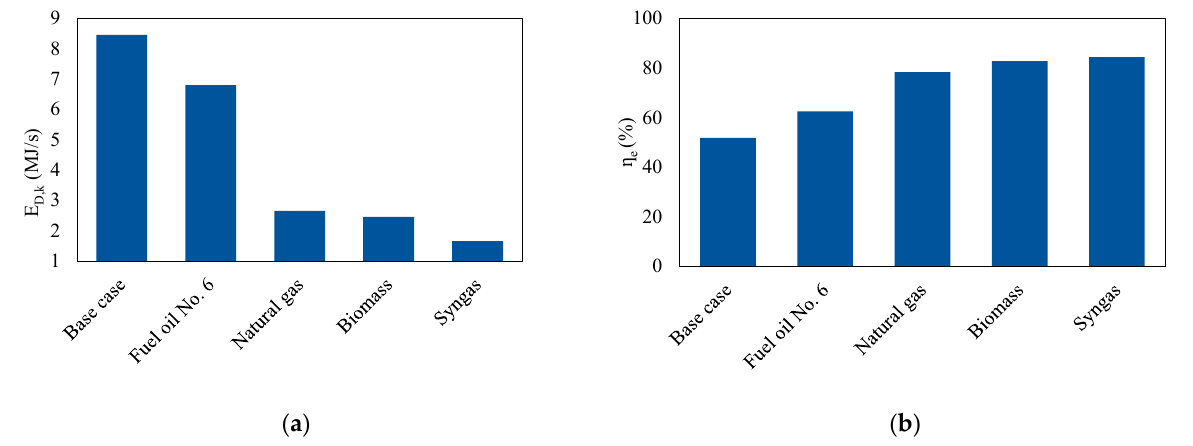
Figure 3. Comparisons of ( a ) the exergy destruction rate and ( b ) the exergy efficiency of the base case and the CCHP using different fuels.